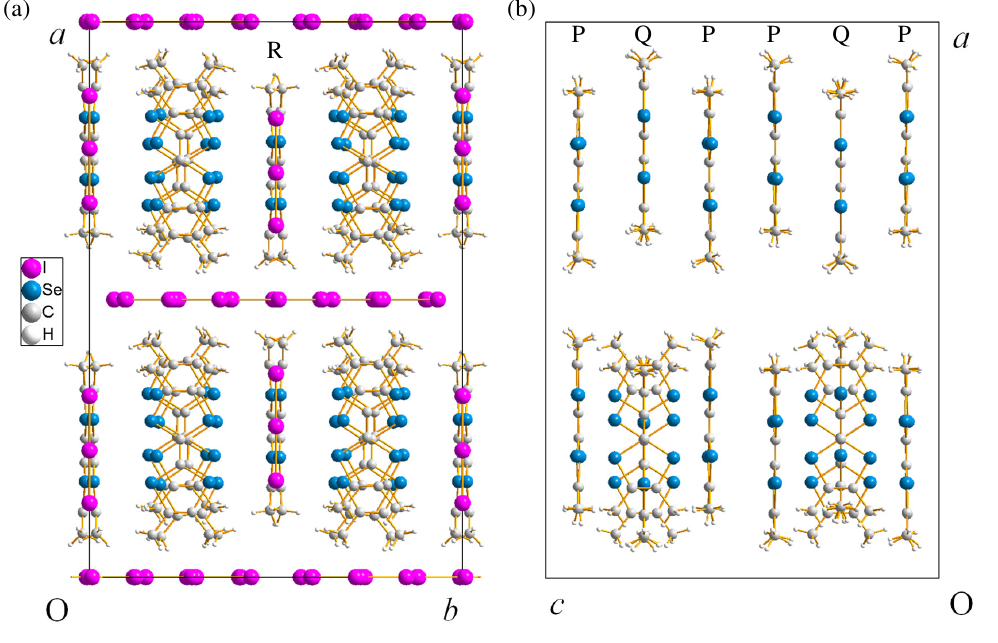
Figure 1. The crystal structure of (TMTSF) 8 (I 3 ) 5 at room temperature viewed along ( a ) the c -axis and ( b ) the b -axis. The crystallographically independent TMTSF molecules are labeled P, Q, and R,